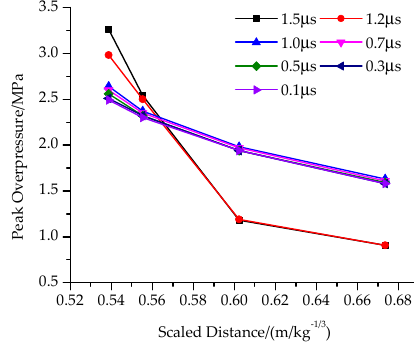
Figure 4. Peak overpressure versus scaled distance under different step size.